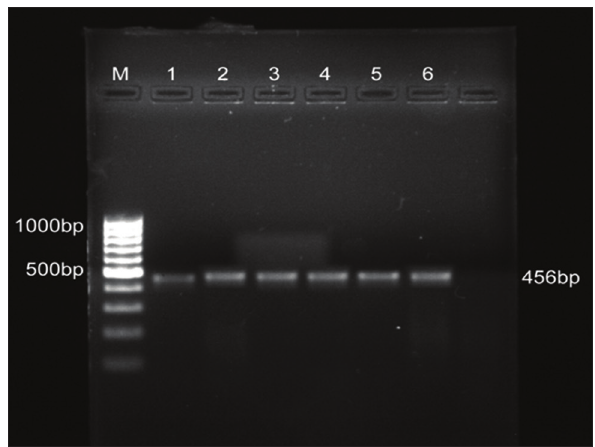
Figure-3: Polymerase chain reaction profile of Listeria innocua positive for hly A. Lane M: 100 bp ladder, lane 1: BD1, lane 2: P1, lane 3: P2, lane 4: H6, lane 5: 1143, Lane 6: